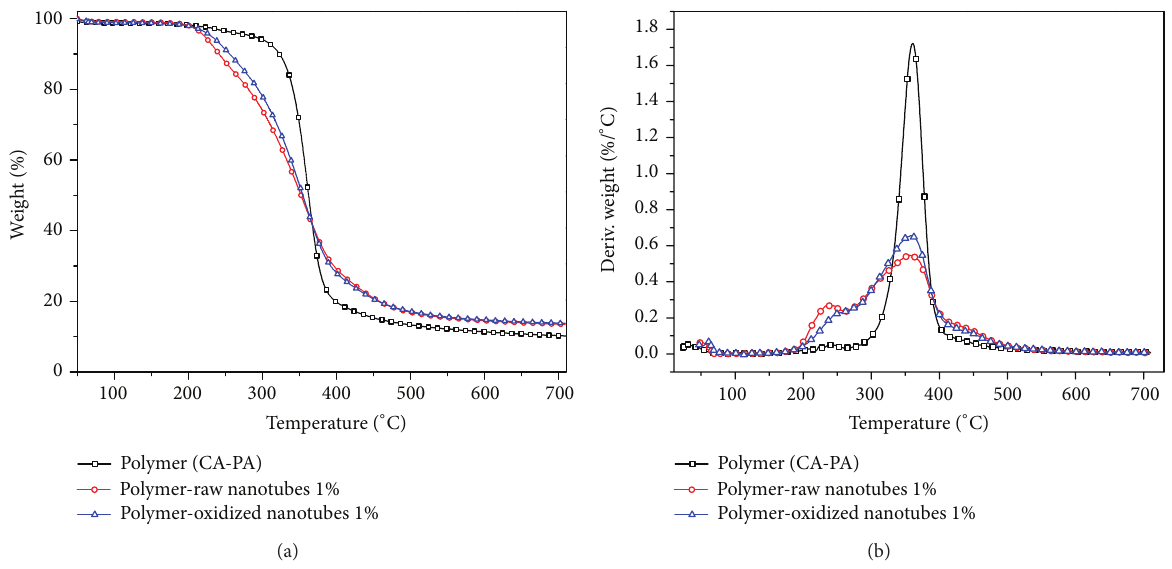
Figure 10: Thermogravimetric curves of polymer (CA-PA) with raw and oxidized carbon nanotubes (1%w).